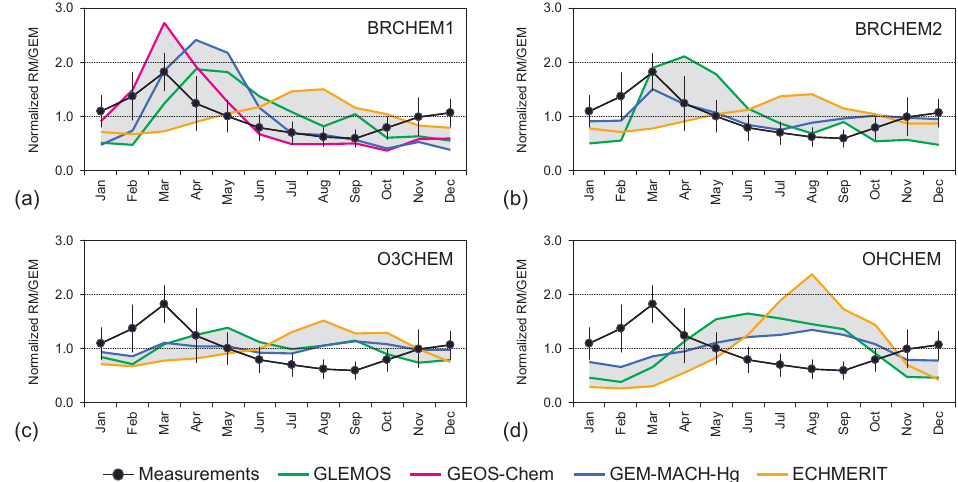
Figure 8. Normalized seasonal variation of monthly ratio of annual mean RM concentration to GEM concentration. Black line with dots shows observations averaged over selected sites (whiskers are standard deviation). Colored lines present model simulations averaged over the same sites for different model experiments: (a) BrCHEM1, (b) BrCHEM2, (c) O3CHEM, and (d)